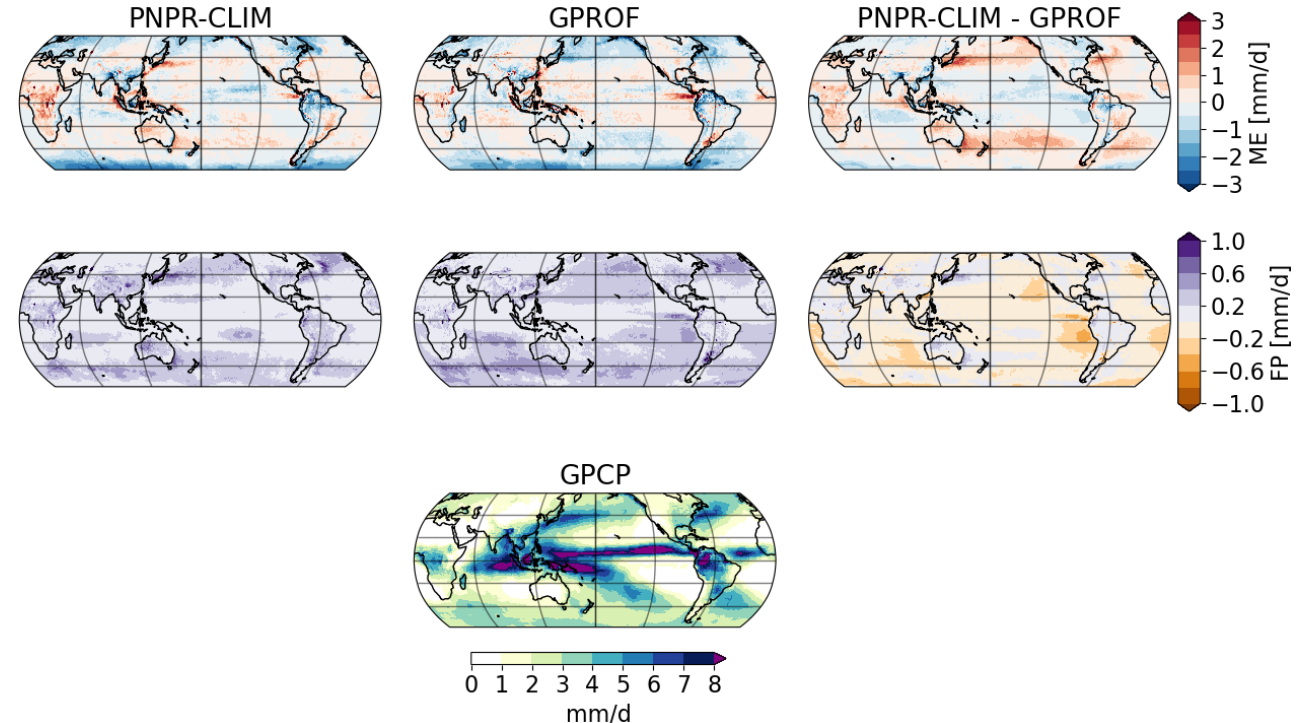
Figure 7. Mean error ME ( upper panels ) and false precipitation FP ( central panels ) maps of PNPR-CLIM ( first column ) and GPROF ( second column ) with respect to GPCP, together with the GPCP mean values ( bottom panel ), for the period 2015–2017 between 60 ◦ S and 60 ◦ N. In the rightmost panels the differences of ME ( upper right panel ) and FP ( central right panel ) are